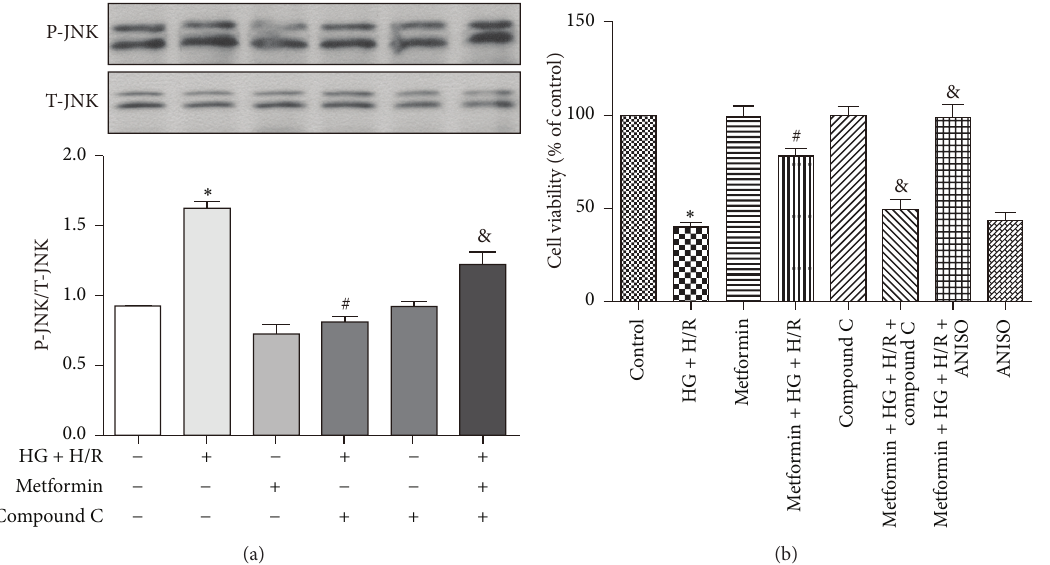
Figure 5: Metformin protects against HG + H/R induced cardiac cell injury by inhibiting JNK signaling pathway, which acts downstream of AMPK. H9C2 cells were treated with HG + H/R, metformin (5mM), metformin + HG + H/R, compound C (1 𝜇 M), metformin + HG + H/R + compound C, ANISO (10 𝜇 M), and metformin + HG + H/R + ANISO. (a) Expression of P-JNK and T-JNK in each of the treatment conditions was measured by Western blots. (b) Effect of a putative JNK activator ANISO on cell viability was determined using the CCK-8 kit. Data are shown as means ± SD of 3 independent experiments. ∗ 𝑃 < 0.05 versus control; # 𝑃 < 0.05 versus HG + H/R; & 𝑃 < 0.05 versus metformin + HG + H/R.